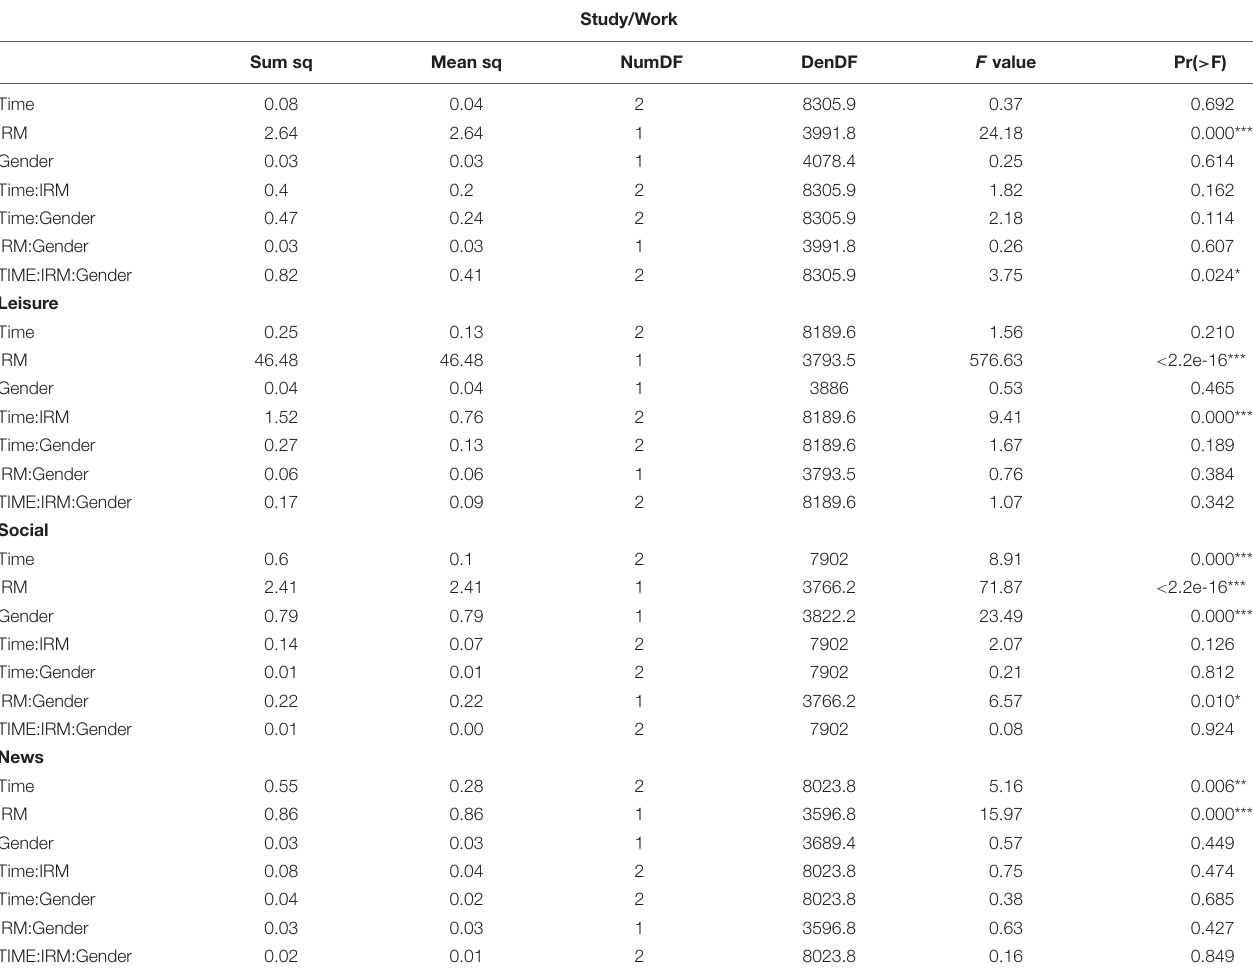
TABLE 2 | Effects of IRM, time, and gender on RF for each type of reading.